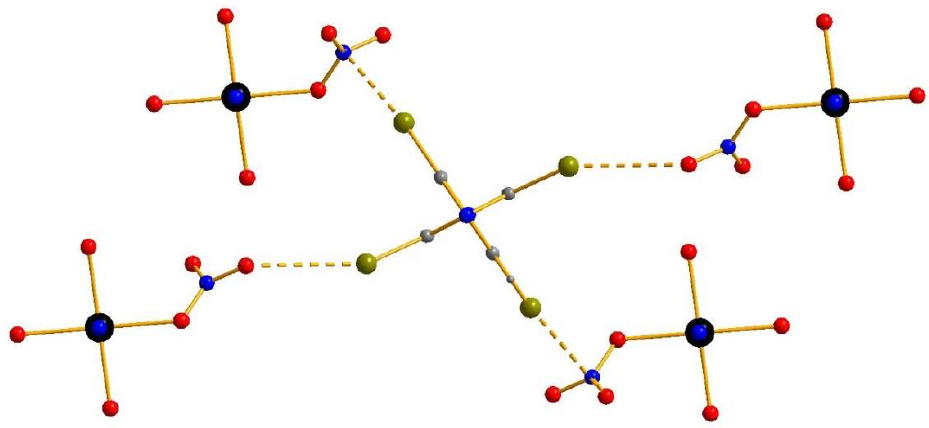
Figure 6. Br ⋯ O interactions in the structure of 2 .